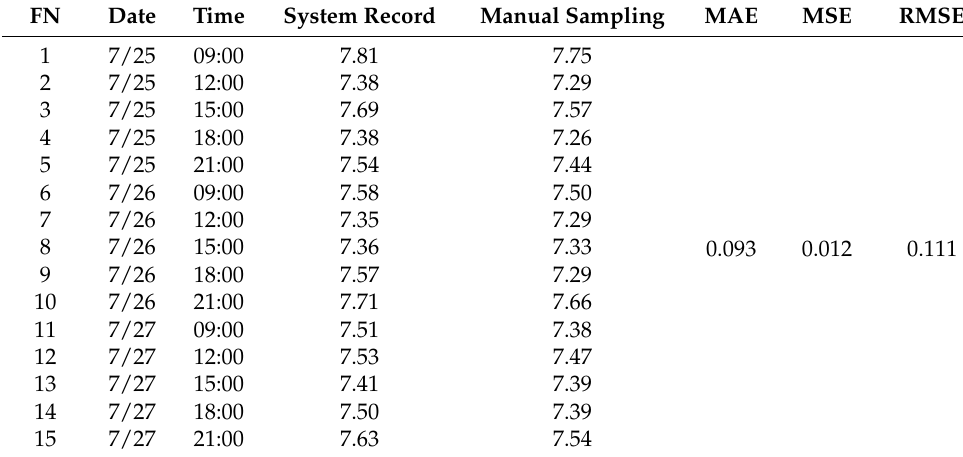
Figure 14. System record value and manual sampling of DO. Table 4. Comparison of the results of DO